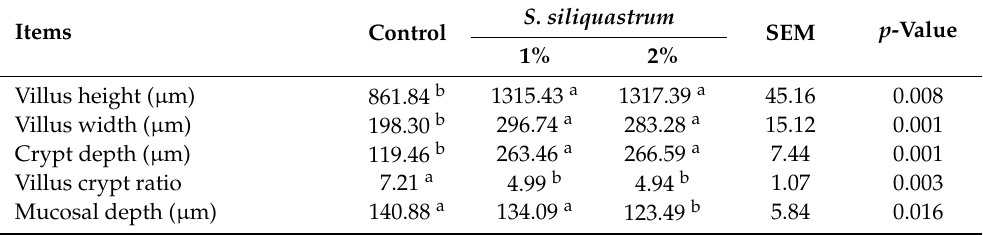
Figure 1. Morphometric measurements of duodenal villus height (VH), villus width (VW), crypt depth (CD) and mucosal depth (MD) of Japanese quail. Scale bar = 100 µ m. Table 7. Effect of S. siliquastrum dietary treatment on intestinal histomorphometry in Japanese